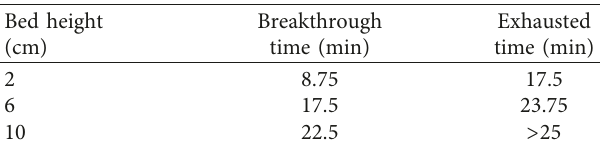
Figure 8: Effect of bed height on breakthrough profile of QPKS (pH � 3, treated volume � 100 ml, flow rate � 4ml/min, and initial fluoride concentration � 2mg/l). Table 5: Breakthrough time and exhausted time at different bed